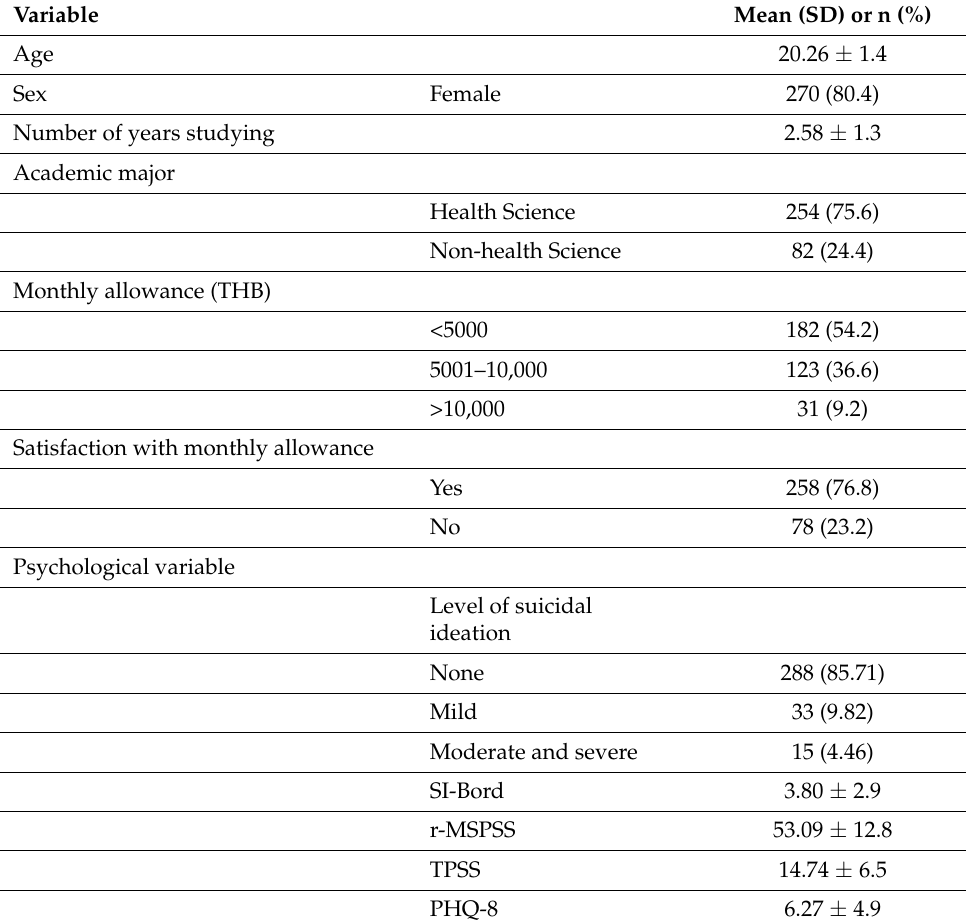
Table 1. Characteristics and demographic data of the overall participants (N =